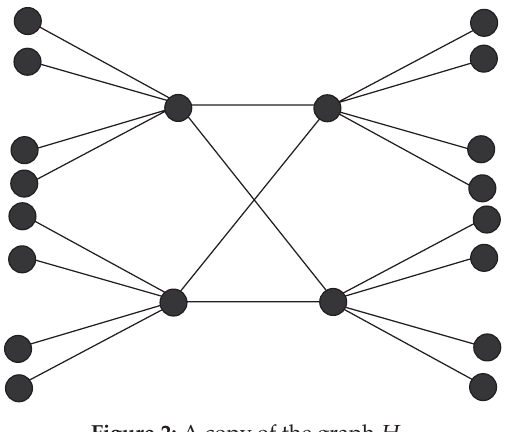
Figure 2: A copy of the graph H 2